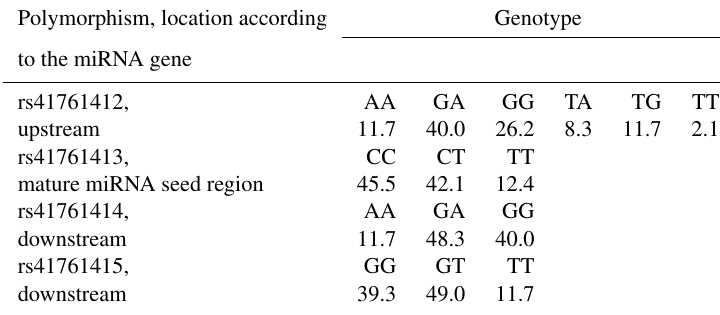
Table 2. Frequencies (%) of genotypes for four polymorphisms ( N =